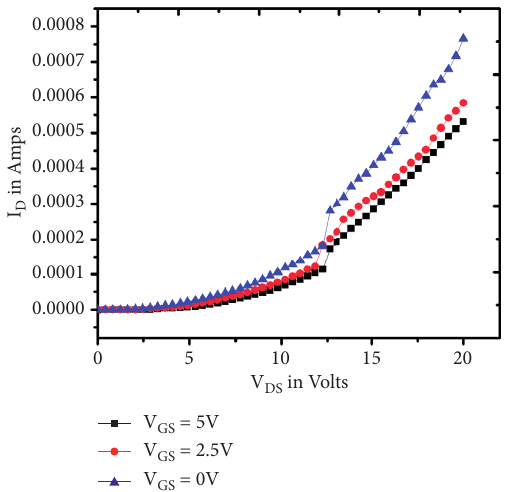
Figure 11: Output characteristics of V of Si-MOSFET.